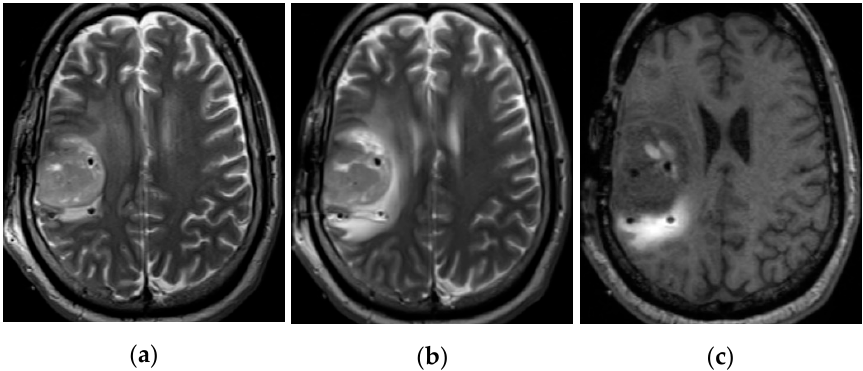
Figure 1. Infusion induces expansion (Axial T2-weighted images, MR1-1 Patient 8). ( a ) After 2 h of infusion, a small amount of edema (bright regions) is visible near an infusion catheter (black dots), posterior to the tumor in this T2-weighted image. ( b ) After 24 h of infusion, the size and intensity of the T2-weighted signal in the nearby white matter has increased. ( c ) T1-weighted imaging after 24 h of infusion shows the distribution of gadolinium tracer).